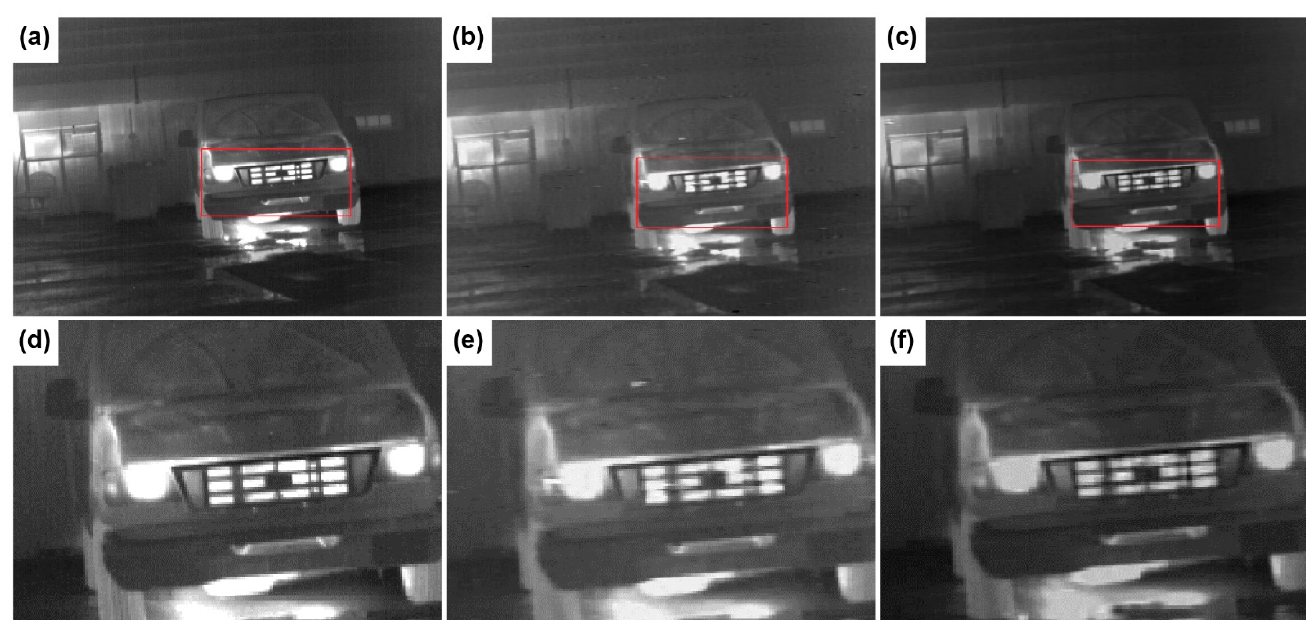
Figure 6. The truck image with different degrees of degradation. ( a ) The original image, ( b ) the 7 ×